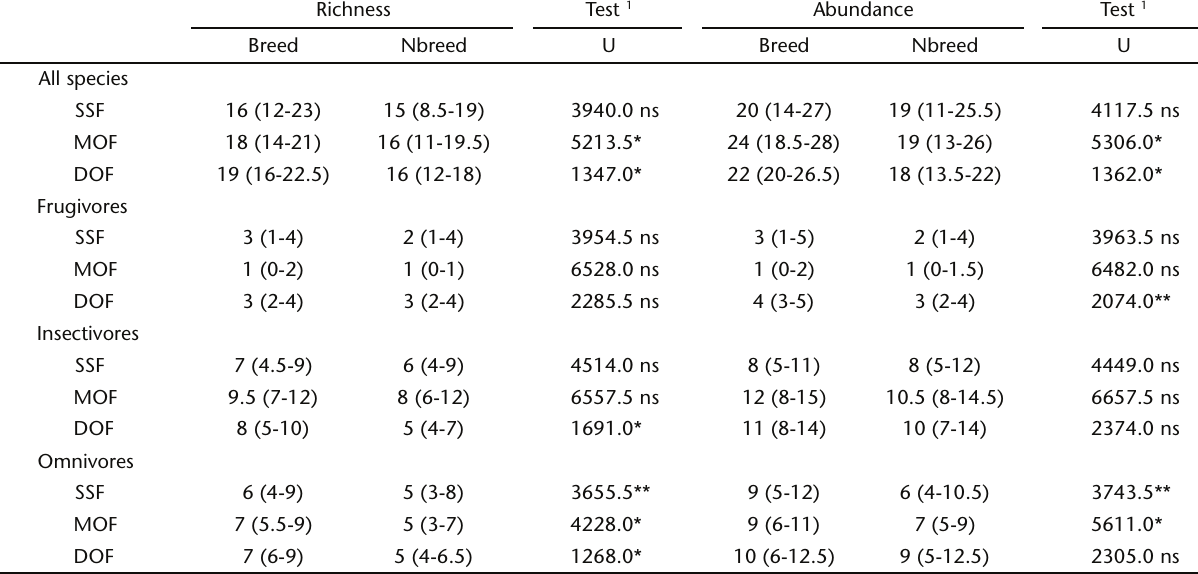
Table II. Median values (range 25-75 quartiles) of number of species (richness) and of contacts (abundance) per point count in the breeding (breed) and non-breeding (Nbreed) seasons in seasonal semi-deciduous forest (SSF), mixed ombrophilous forest (MOF),